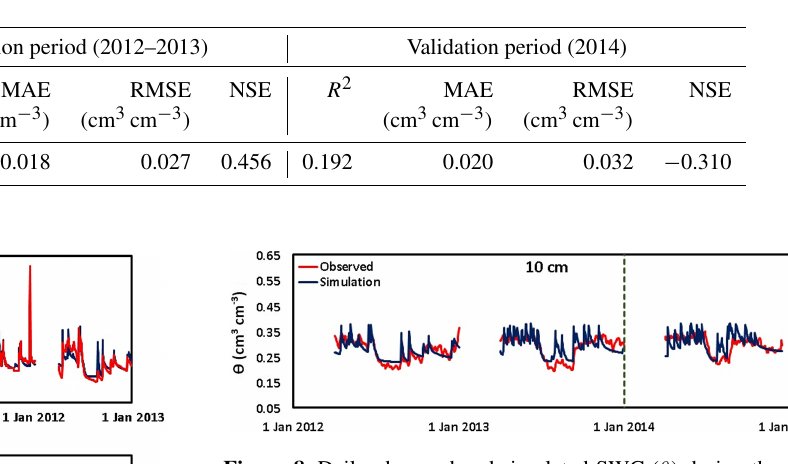
Table 4. Goodness-of-fit measures for simulated and observed SWC data during the calibration period (2012–2013) and validation period (2014) at the CRNP location.